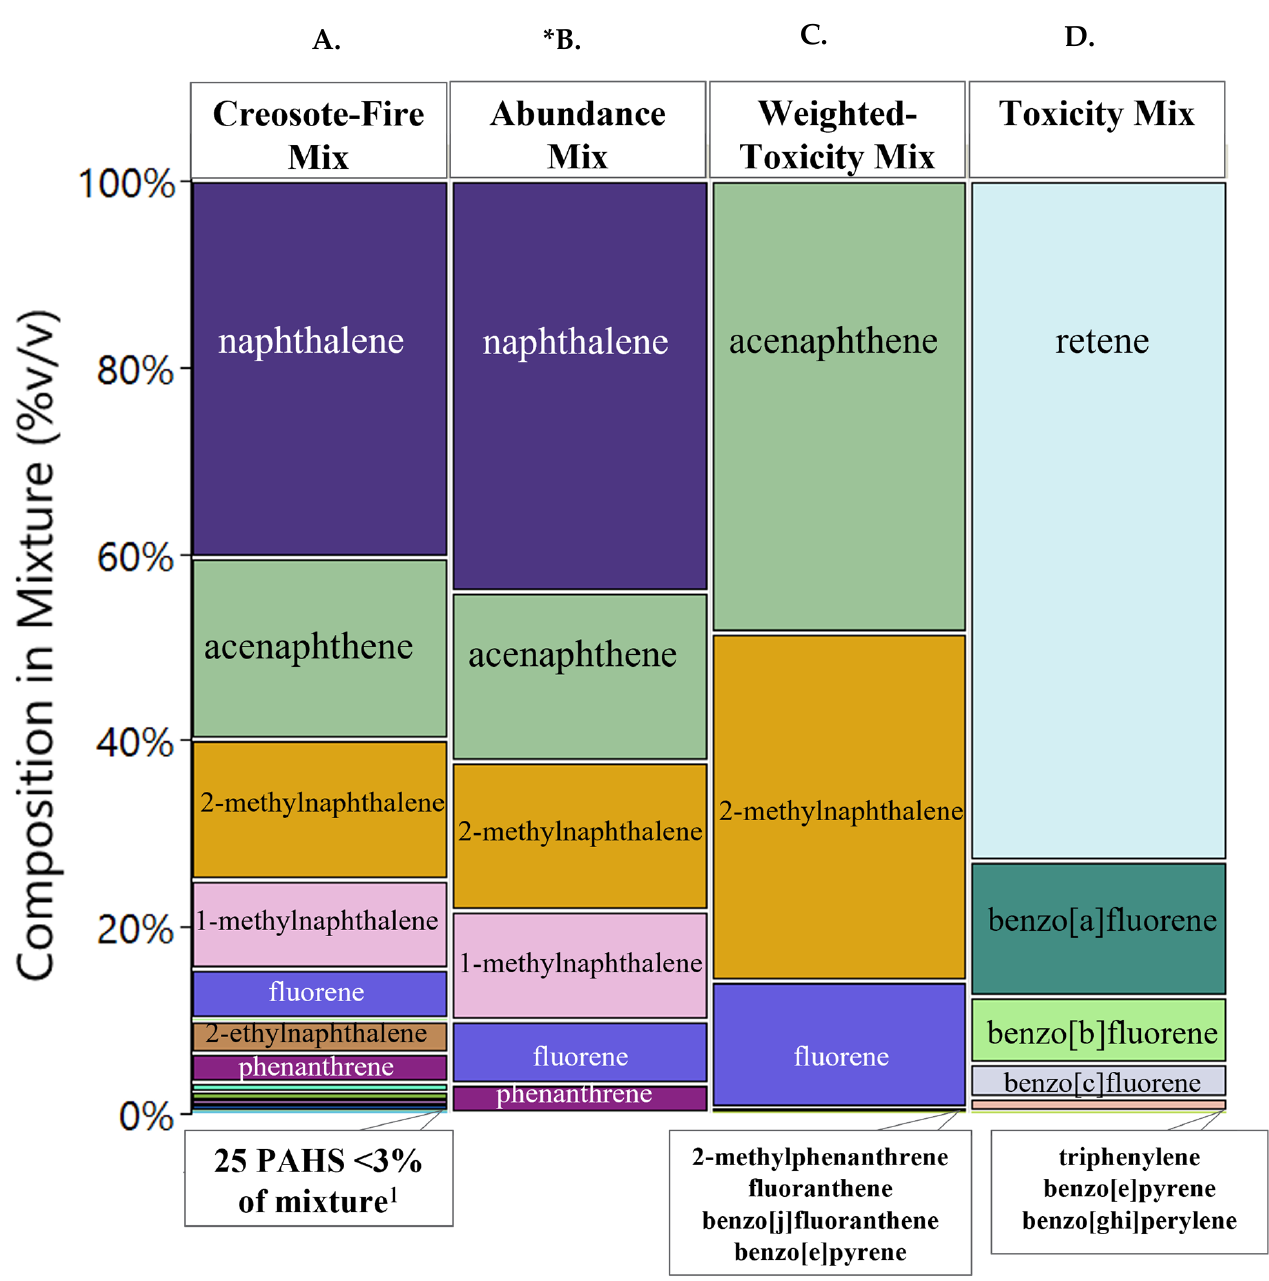
Figure 1. Chemical Composition of Mixtures. Chemicals greater than 3% v / v in the mixture are shown in colored sections. Colors and area of color correspond to a given chemical and the % v / v of that chemical in its respective mixture. Anything less than 3% v / v is listed below its respective mixture figure. ( A ). 30 chemicals identified above detection limits out of 63 PAHs air samples were analyzed for. ( B ). Chemicals prioritized strictly based on abundance, top seven PAHs that made up over 97% v / v in Creosote-Fire Mixture were selected. ( C ). Chemicals prioritized using empirically derived and predicted toxicity metrics. ( D ). Chemicals prioritized by weighting empirical and predicted toxicity metrics with chemical concentrations. 1 Full list of chemical composition in each mixture can be found in Tables S9 and S10. * 2-ethylnaphthalene was not included in Abundance Mix due to unavailability of the standard during synthesis of this